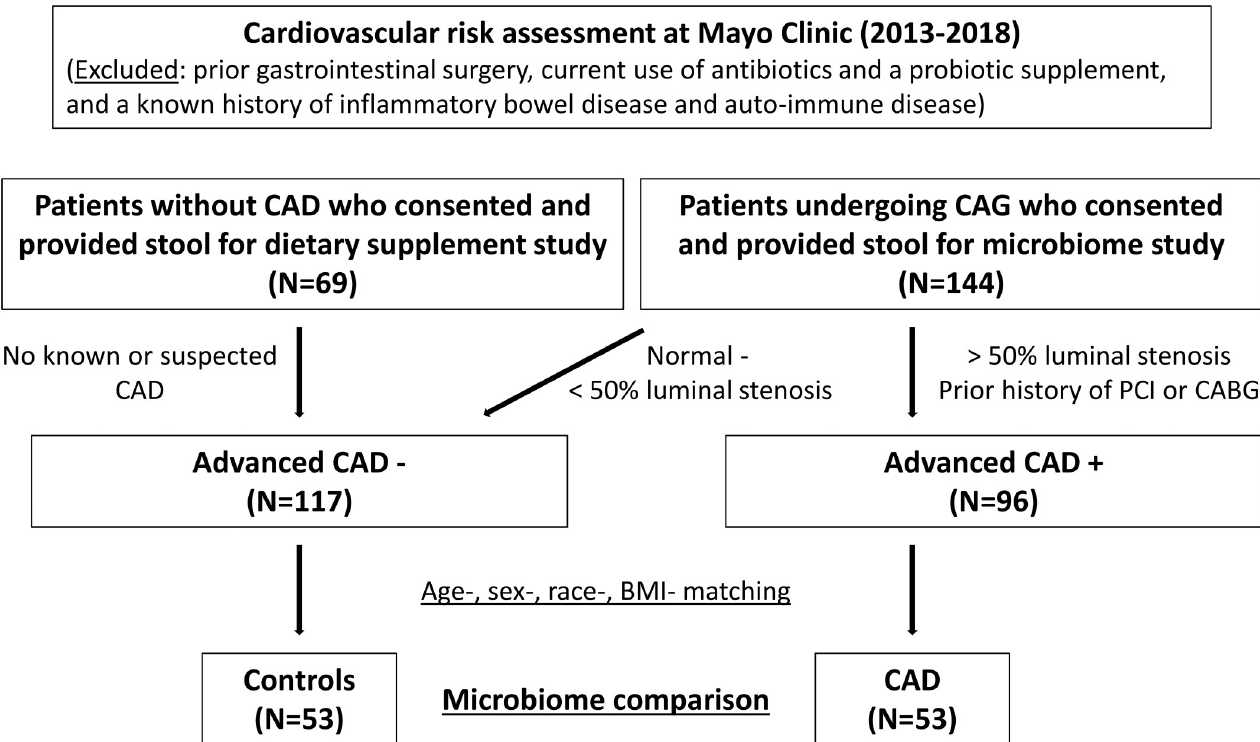
Fig 1. Flowchart explaining CAD patients and controls recruited for the study. We enrolled 213 participants (96 patients with advanced CAD and 117 patients without advanced CAD) in the microbiome study. Fifty-three advanced CAD patients and age-/sex-/race-/BMI- matched participants without advanced CAD were ultimately